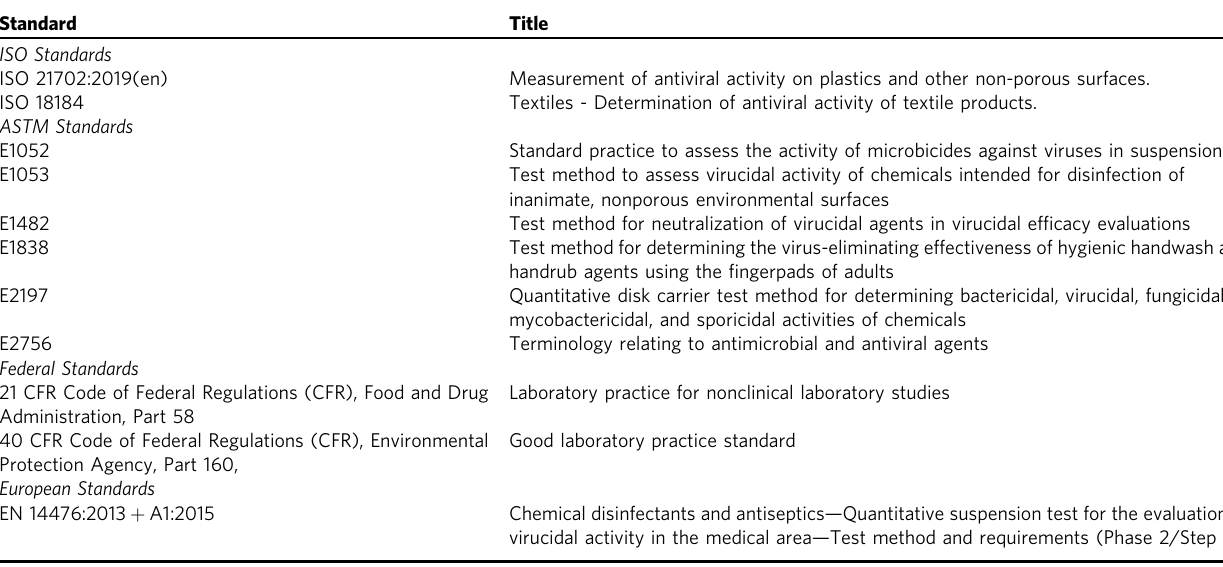
Table 1 Overview of international standards to assess virucidal activity on surfaces and the effect of virucidal agents. Standard ISO 18184 Textiles - Determination of antiviral activity of textile products. ASTM Standards